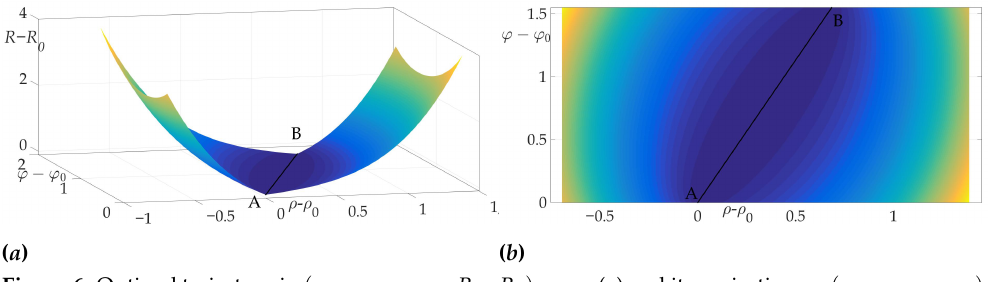
Figure 6. Optimal trajectory in ( ρ − ρ 0 , ϕ − ϕ 0 , R − R 0 ) space ( a ) and its projection on ( ρ − ρ 0 , ϕ − ϕ 0 ) plane ( b